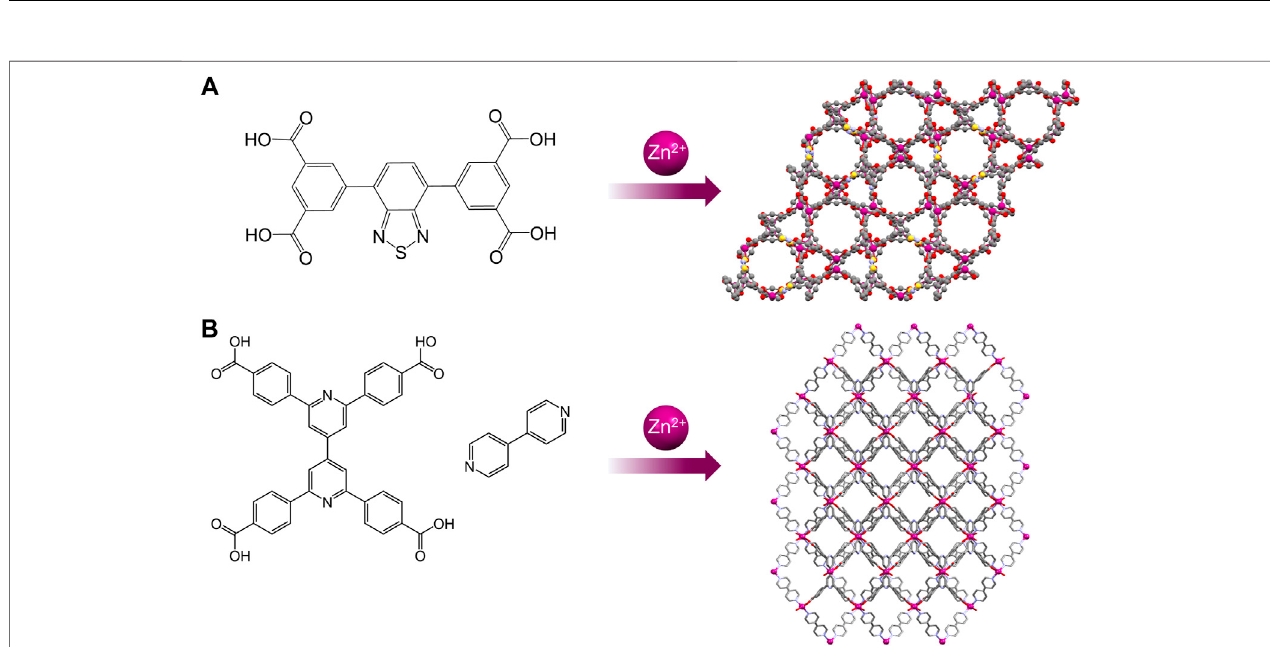
FIGURE 3 | Some representative structures of Zn-MOFs for pH and temperature measurement. (A) H 4 L tetracarboxylic acid ligand and the MOF ZJU-21 framework viewed along the c direction, from ref (Zhao et al., 2017); (B) ligands and 3D framework representation of the Zn MOF viewed along the c direction, form ref (Yang et al.,